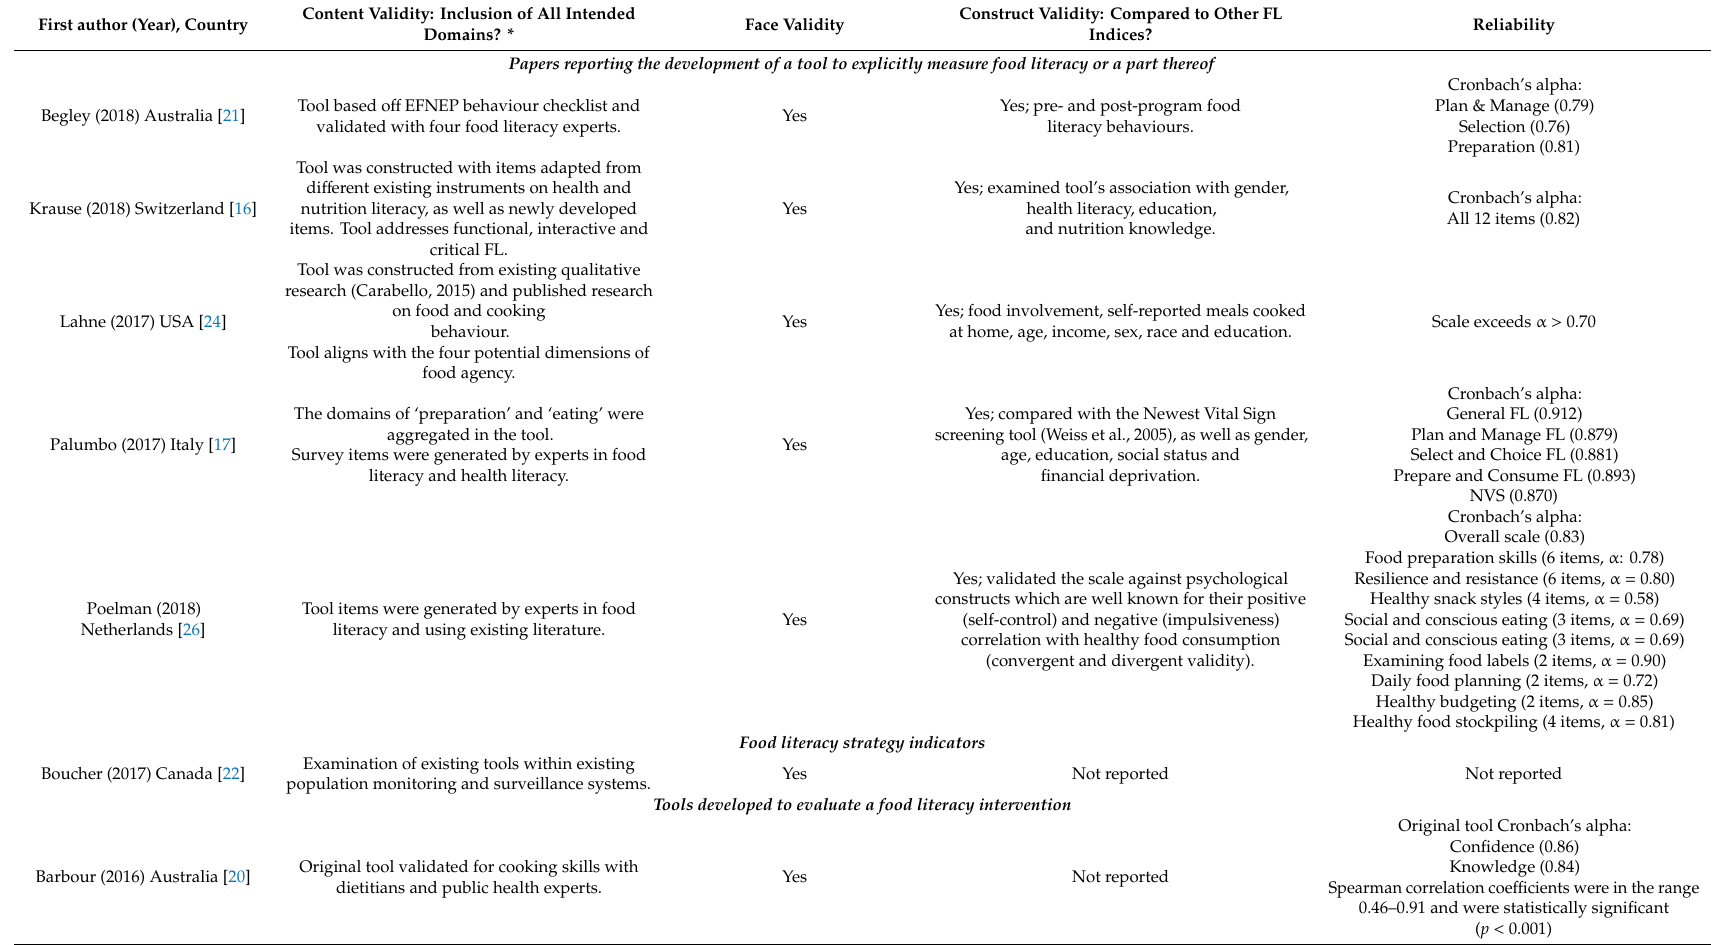
Table 3. Content, face and construct validity and reliability of reviewed food literacy